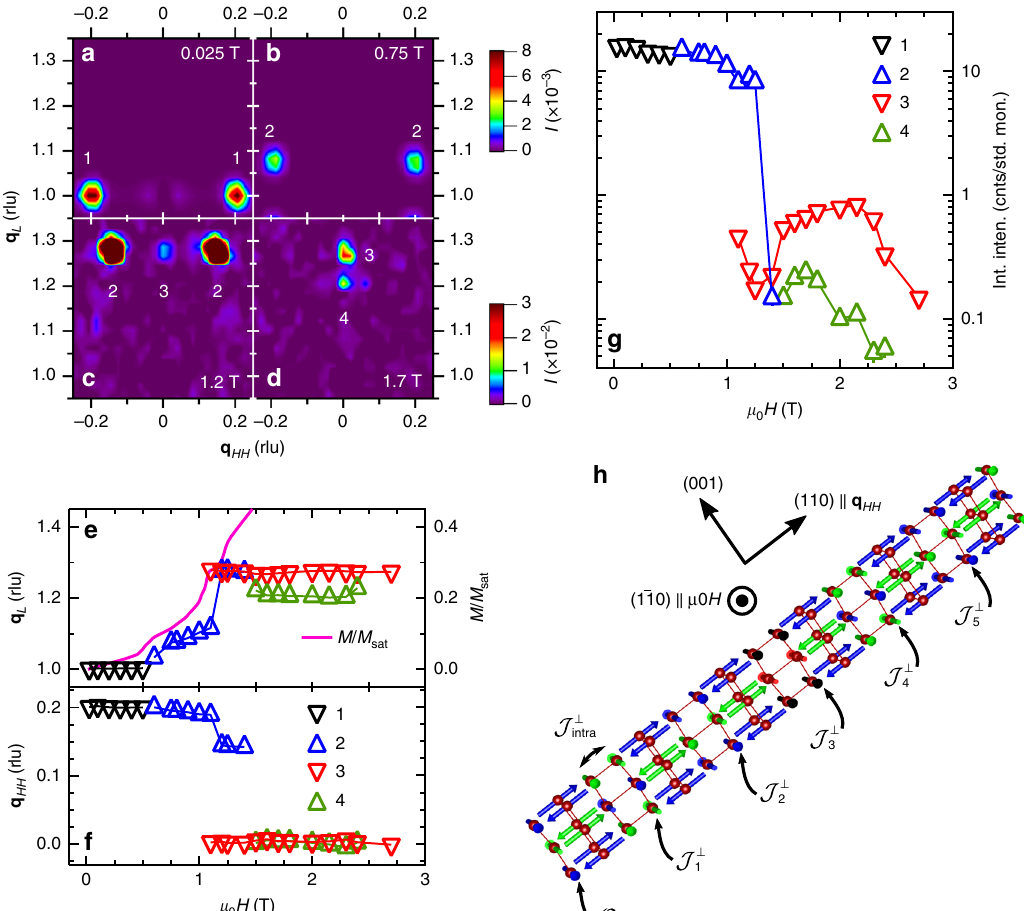
Fig. 4 Magnetic order and phase diagram of Yb 2 Pt 2 Pb. a – d . Time of fl ight data with energy transfer E = 0 in the q HH , q L plane, measured at T = 0.1 K in fi elds of 0.025T ( a ), 0.75 T ( b ), 1.2 T ( c ), and 1.7 T ( d ). The magnetic Bragg diffraction peaks in each part of the phase diagram are labeled 1 – 4. ( e , f ) The location in reciprocal space along q L ( e ) and q HH ( f ) of the magnetic Bragg scattering as a function of the fi eld in the regions plotted in parts a – d . Data shown are an average, symmetrized about q L = 1 and q HH = 0. The open symbols correspond to the peaks labeled 1-4 in panels b – e , with black indicating peak 1, blue peak 2, red peak 3, and green peak 4. Magnetization divided by the saturation magnetization M / M sat as a function of the fi eld along the (110) crystal direction is also shown in panel e (pink line, right axis), demonstrating the initial trend, M / M sat ≈ ( q L − 1) and the concurrence of the jumps in magnetization with the abrupt changes in the position of elastic scattering. ( g ) The intensity of the diffraction peaks in parts b – f . The AFM order that emerges for μ 0 H > 1 T is considerably weaker than the low fi eld order, while the low fi eld order falls off very abruptly for μ 0 H > 1.2 T. Symbols are the same as in panels e , f . ( h ) The zero fi eld magnetic structure and dipole interactions in Yb 2 Pt 2 Pb. Yb moments in fi ve unit cells are shown along the diagonal, (110) direction, with the interchain couplings, J ? , as indicated. The Yb SSL AFM layers are highlighted (blue and green arrows), with the periodicity given by FM n pairs every fi ve unit cells (black and red